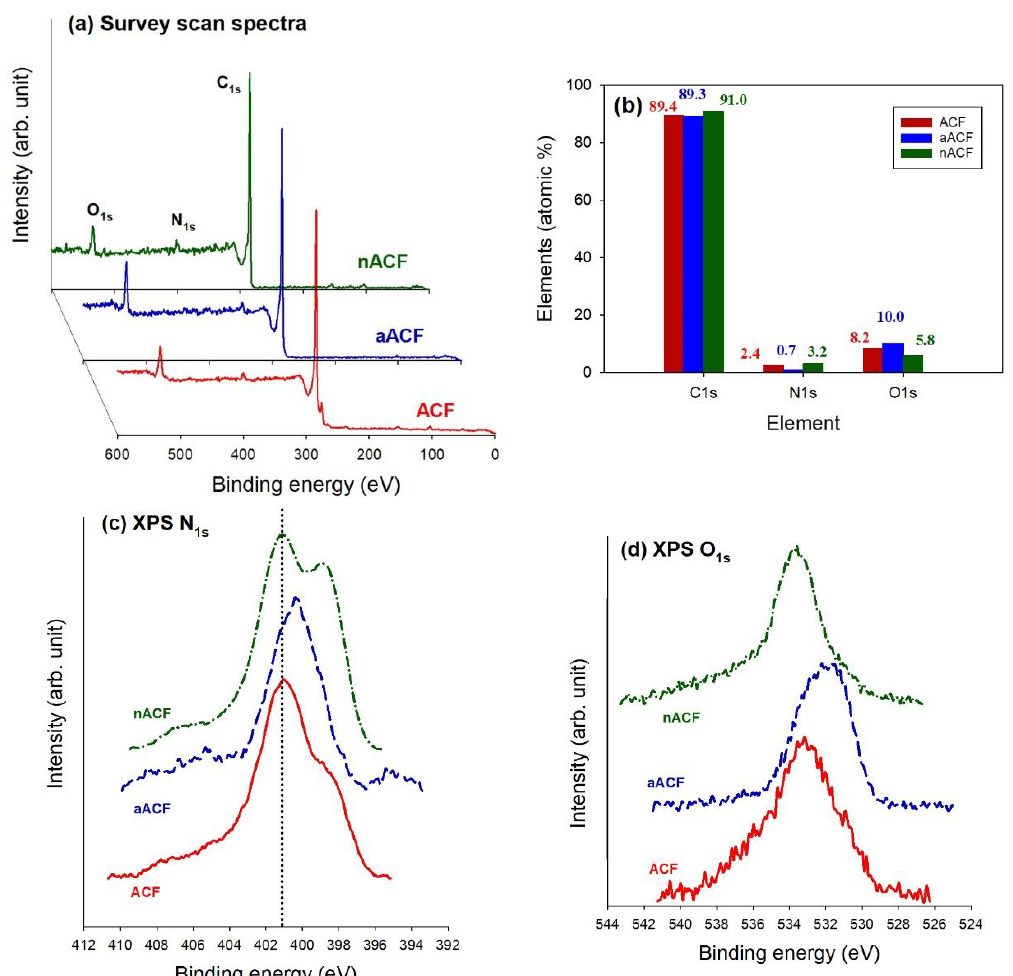
Figure 3. The X-ray photoelectron spectroscopy (XPS) of the samples: ( a ) survey scan spectra; ( b ) atomic ratios; ( c ) N 1s peaks; ( d ) O 1s peaks.